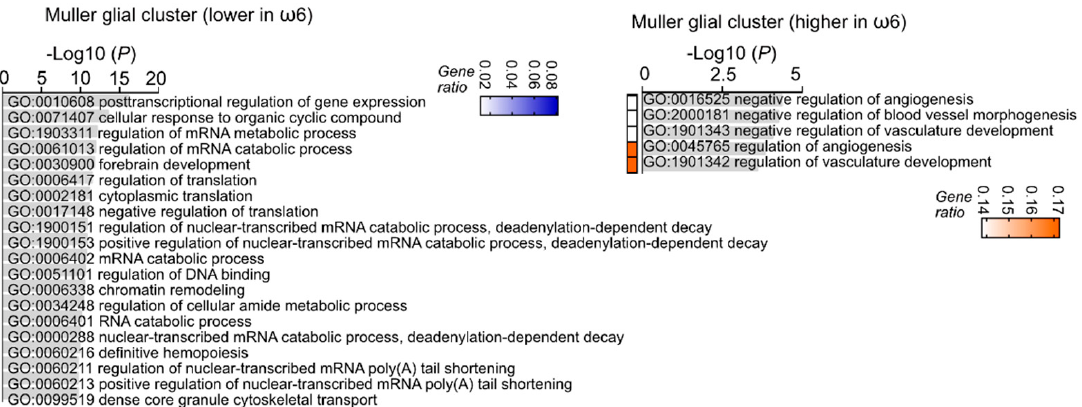
Figure 6. ω -6 versus ω -3 increased Müller glial angiogenic factor expression with single-cell analysis. In the Müller glial cell of ω -6 vs. ω -3 LCPUFA-fed Phase I ROP mice, the lower expression of genes was associated with post-transcriptional regulation, and the higher expression of genes was associated with regulation of angiogenesis and vasculature development related gene ontology terms. Adjusted p -values for enriched gene ontology (GO) terms are shown in bar graphs ( p < 0.05). Gene ratio for each pathway is shown in heatmap.